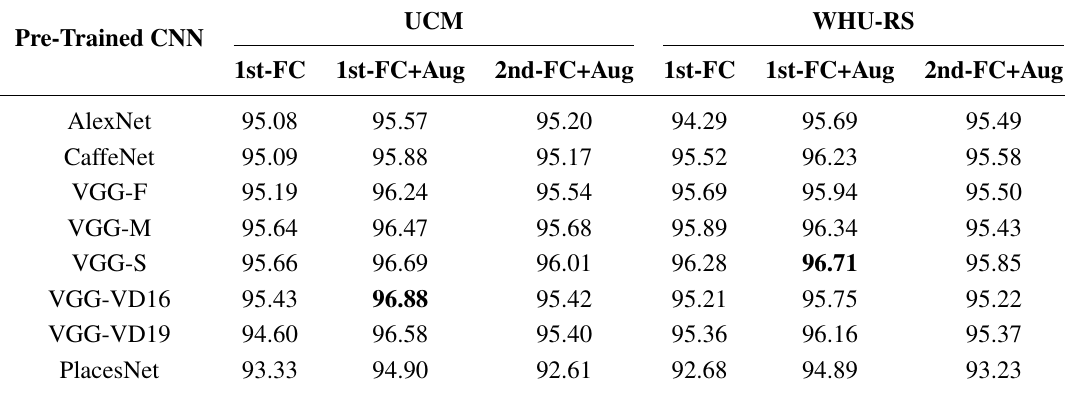
Table 3. Performance Comparison of CNN Features (from the first FC layer) and the Effect of Data